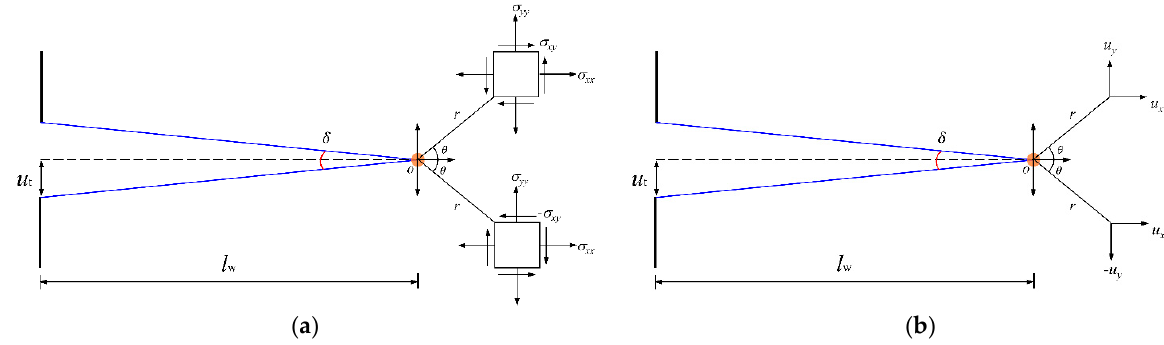
Figure 8. ( a ) The stress field and ( b ) the displacement field with respect to the crack tip. Assuming that the surface angle of the crack tip of surrounding rock in a distant zone is small, meanwhile pw is governed by the residual tensile strength f tr = η f t , with η